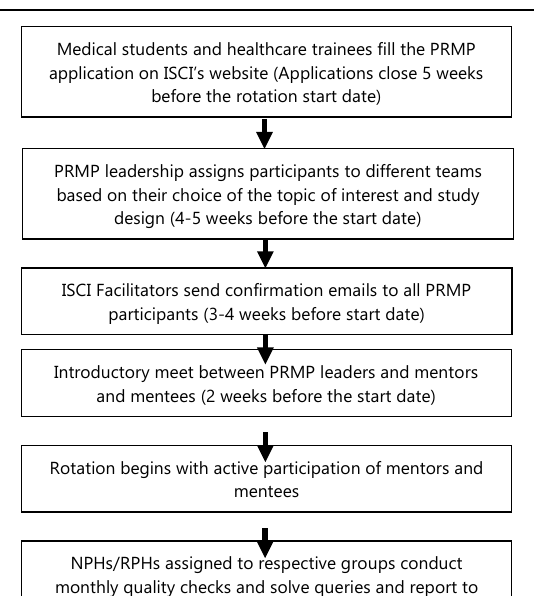
Figure 2 . Process of Team Allotment by PRMP